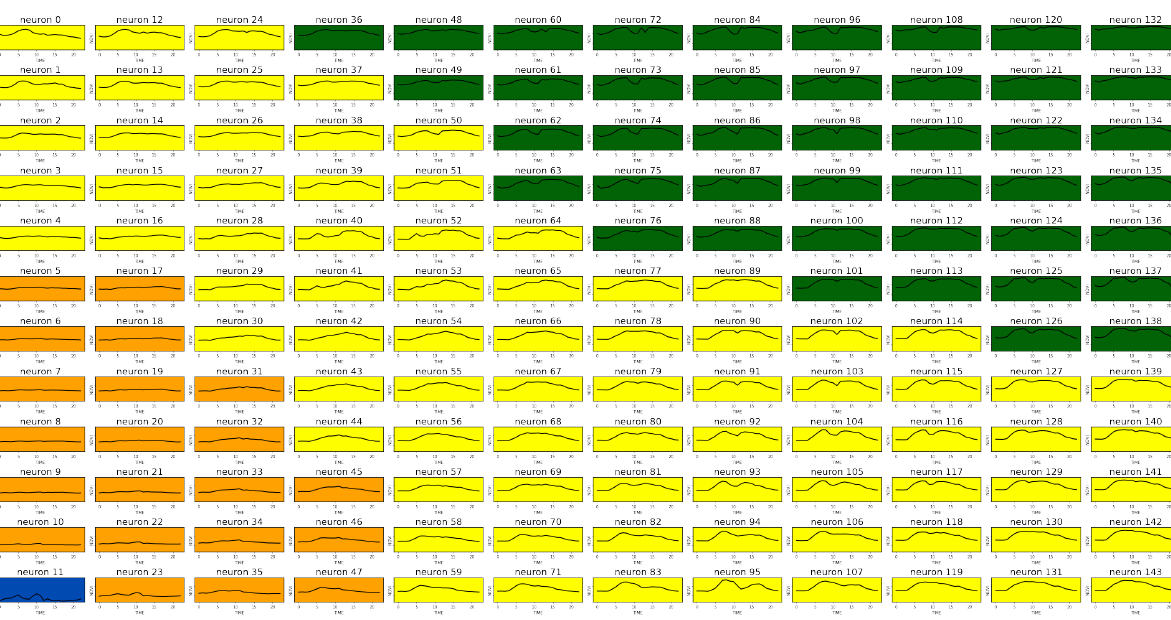
Figure 7. Dendrogram Results.